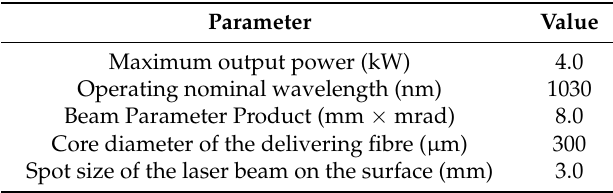
Table 1. Main technical features of the laser source.